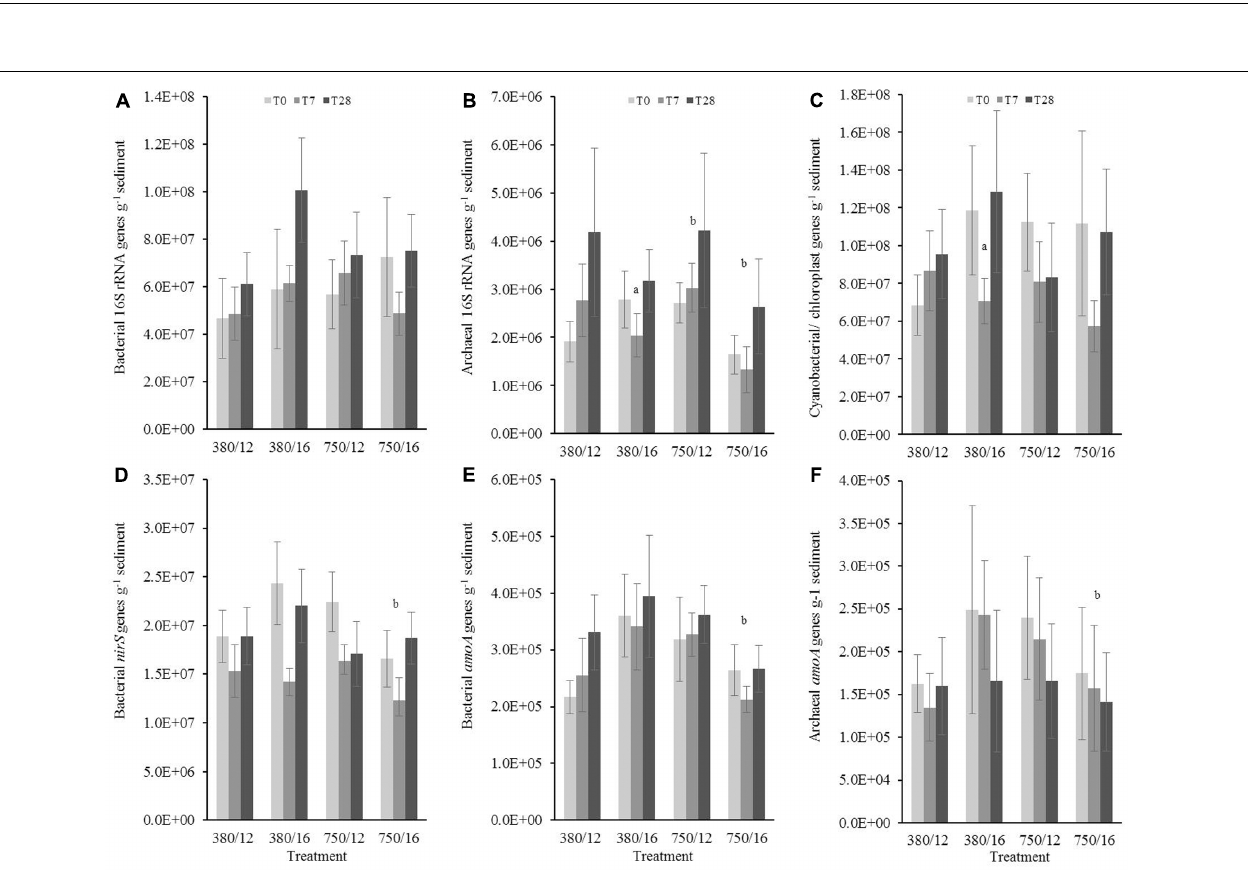
FIGURE 4 | The effects of CO 2 and/or temperature on the abundance (g − 1 sediment) of (A) bacterial 16S rRNA, (B) archaeal 16S rRNA, and (C) bacterial nirS genes in the bottom layer (0.5–2.5 cm) of muddy sediment. Four syringe cores were taken at each time point (T0, light gray; T7, dark gray; and T28, black) from each environmental treatment ( x -axis). Significant effects from the model output are indicated by the letter a (where there is an interaction with day); b (interaction between elevated CO 2 and elevated temperature). Error bars represent standard deviation of repeated measurements ( n = 4) from treatment replicates ( n = 3).